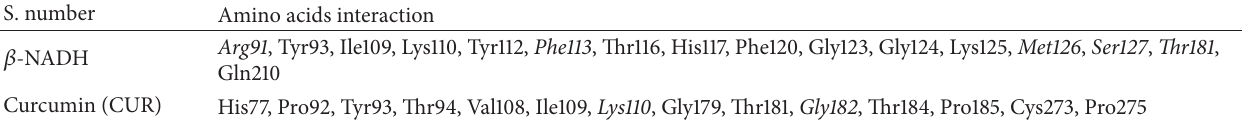
Table 1: Amino acids showing hydrogen bond (italic) and hydrophobic interaction. S. number